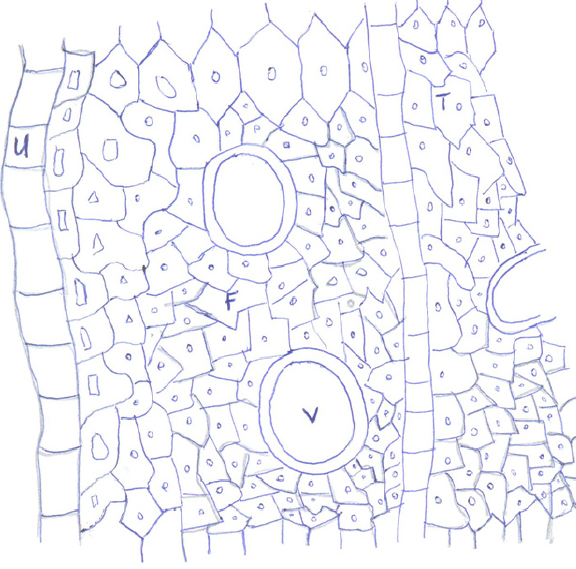
Fig. 1. Transverse Section (TS) of Vitellaria paradoxa wood U = Uniseriate ray; F = Fibre; V = Vessel; T = Tracheid; B = Bordered pit; S = Simple pit ×40